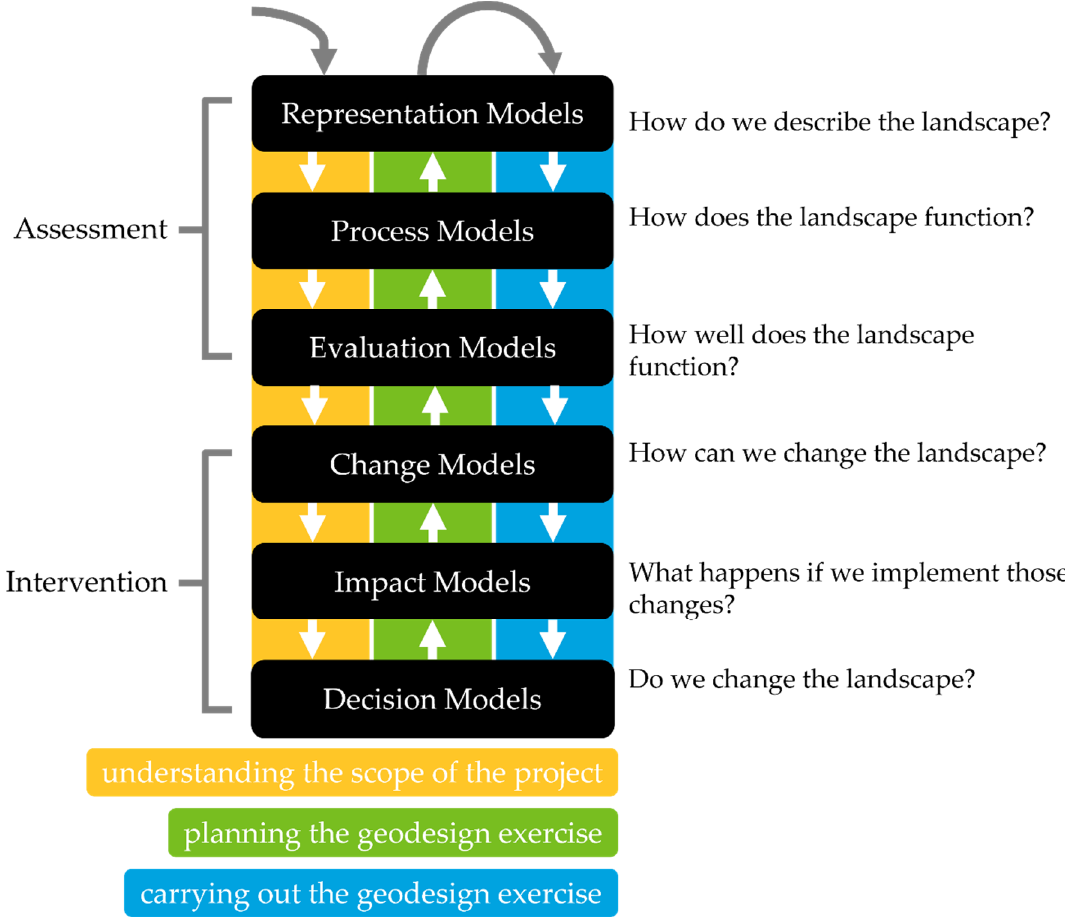
Figure 1. This visual aid—adapted from Steinitz [21]—represents a framework for geodesign. Each vertical column of arrows represents one of three phases: understanding the scope of the geodesign exercise, planning the geodesign exercise, and carrying out the geodesign exercise